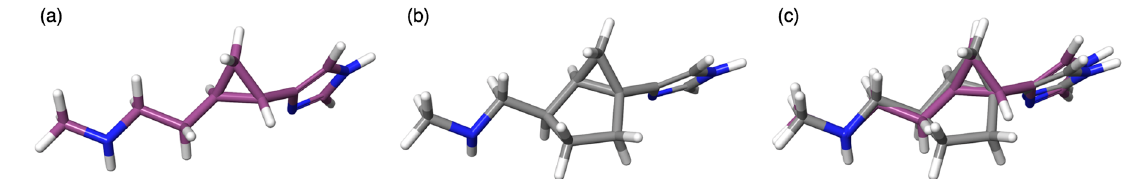
Figure 5. The most stable conformation of the syn -form in 3 ( a ) and 7 ( b ) by conformational search using MacroModel 10.9. (force field: MMFFs, solvent: H 2 O); ( c ) Superimposition of the stable conformation of 3 and 7 . The chlorobenzyl moiety was replaced with a methyl group to simplify the structures.